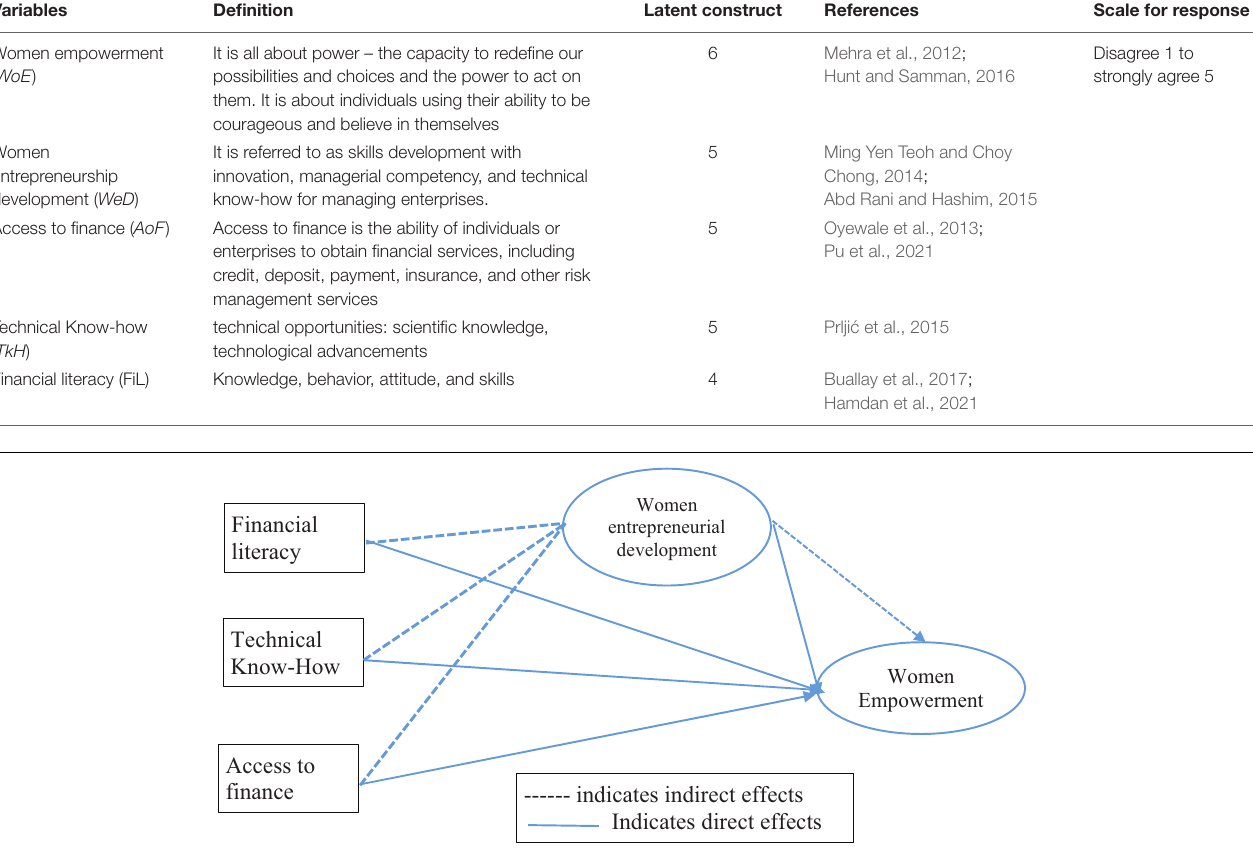
TABLE 2 | Measurements of variables.